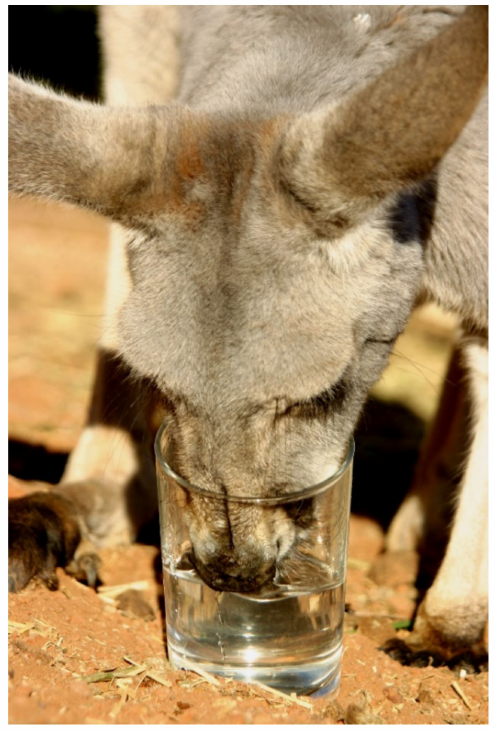
Figure 6. Red kangaroo drinking from a small narrow water source which would be inaccessible to a like-sized sheep or cow. (Image by Ulrike Kloecker reproduced with